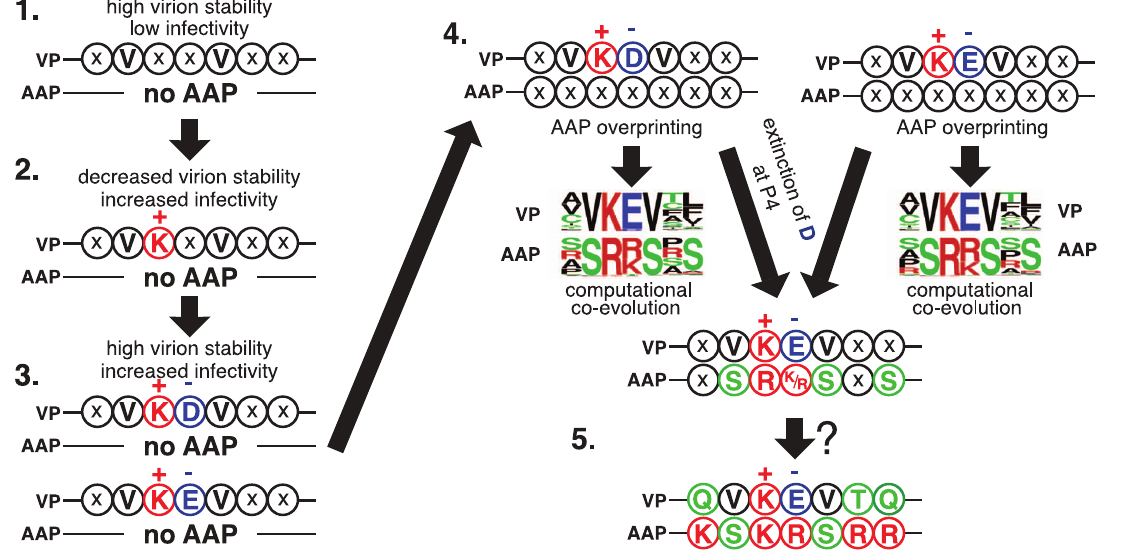
Figure 9. A hypothetical model for a mode of co-evolution of VP/AAP-overlapping heptapeptides. (1) The heptapeptide VP region in the evolutionarily most primitive form when no AAP exists is shown. (2) Acquisition of lysine (K) at VP P3 increases infectivity and is fixed preferentially, but may decrease virion stability. (3) Due to the neutral-neutral or basic-acidic structural constraints imposed on VP P3 and P4, aspartic acid (D) or glutamic acid (E) is favorably placed at P4. (4) AAP overprinting takes place on either xVKDVxx or xVKEVxx sequence motif of VP. A computational co-evolution analysis of xVKDVxx or xVKEVxx-coding DNA predicts evolutionary extinction of VP carrying aspartic acid (D) at P4 and emergence of AAP exhibiting a xSR(K/R)SxS consensus sequence. (5) The overlapping ORF further evolves into the present form by a mechanism that has yet to be elucidated.